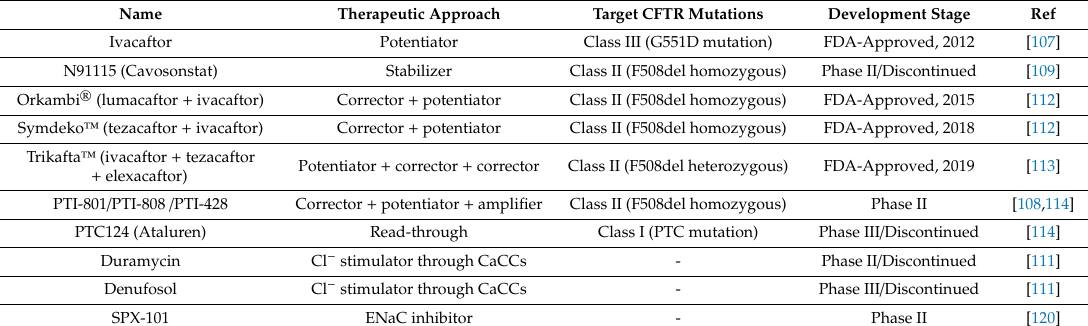
Table 1. Cystic fibrosis (CF) small molecule therapies and their targeted